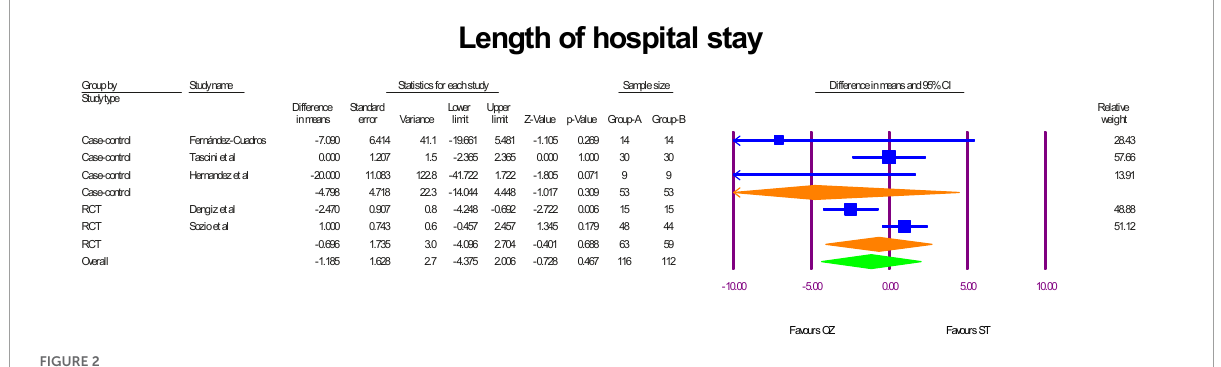
FIGURE2 A forest plot of hospital stay lengths based on study type, comparing OZ and ST groups (Group A = OZ, Group B = ST).